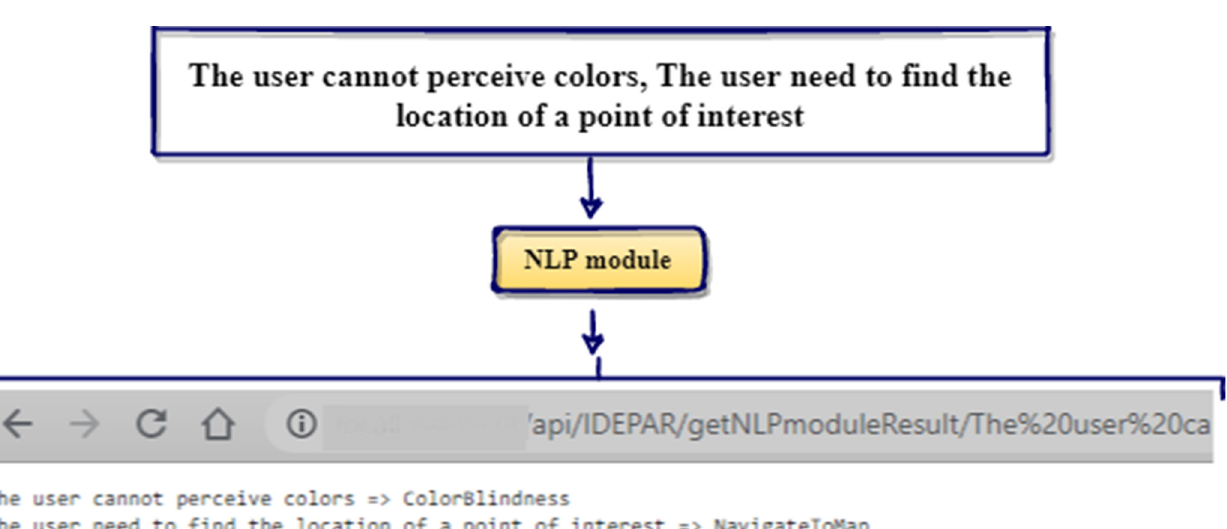
Figure 11. NLP module results for DPS-1.